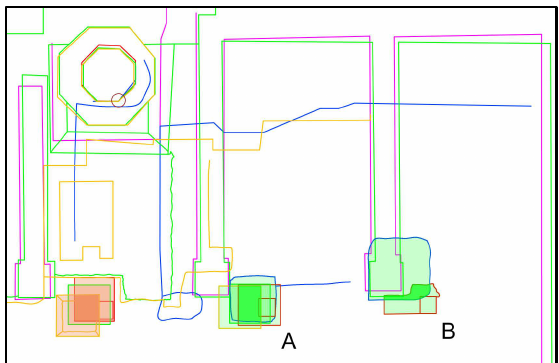
Figure 12 . Vector drawing showing the overlapping position of the pilasters.